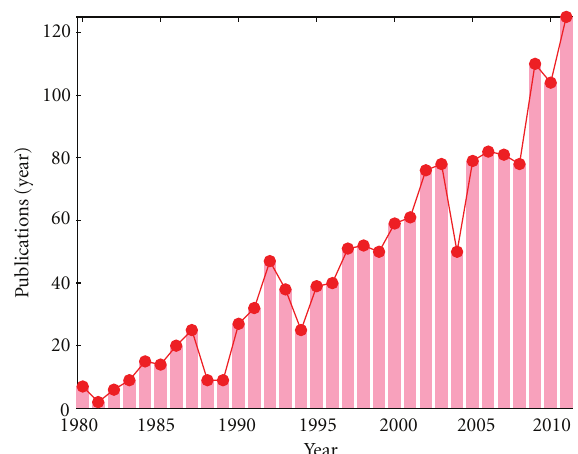
Figure 1: Number of publications by years dealing with one or another aspect of Svalbard meteorology according to ISI Web of Science data